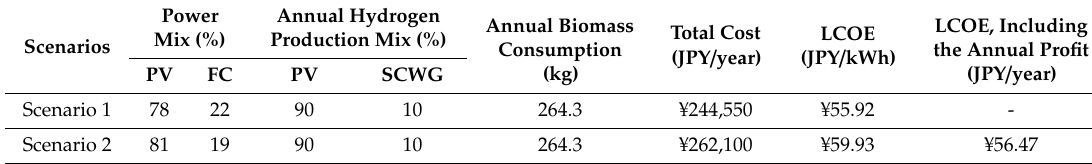
Table 6. Techno-economic analysis results for the two